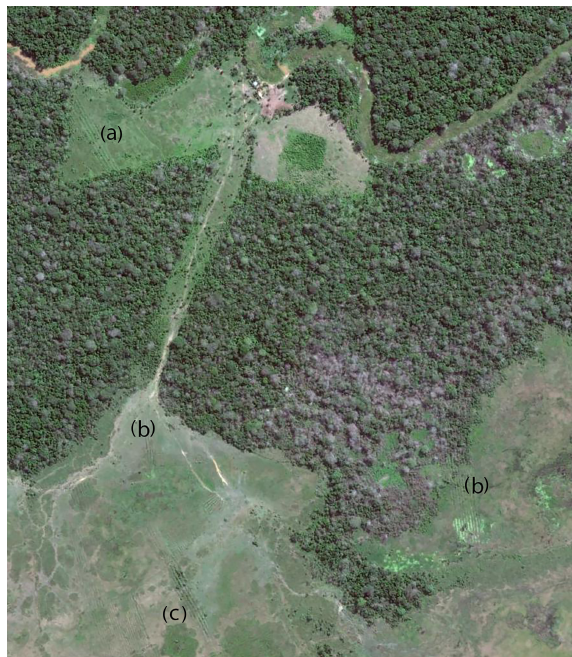
Figure 14. The location of raised fields in the proximity of a Cu- berene River paleochannel (for location see the red box in Fig.